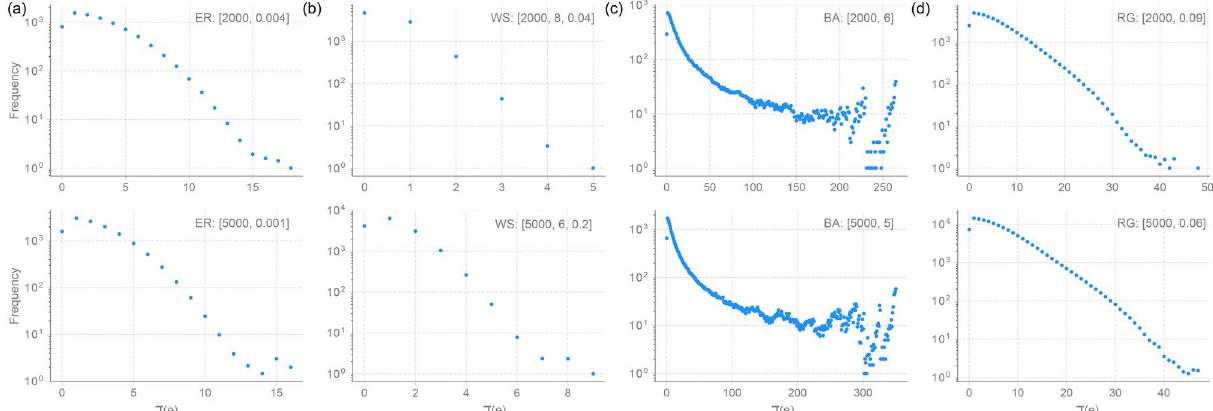
Figure 4. DD distributions in 4 different synthetic networks. ( a ) Erdös–Rényi (ER). ( b ) Watts–Strogratz (WS). ( c ) Barabási–Albert (BA). ( d ) Random Geometric (RG). For each model, the parameters used are indicated besides it in parenthesis. For ER model, the parameters are number of vertices n and probability p of connecting an edge between any pair of vertices. For WS model, the parameters are number of vertices n , the number of neighbours k to which each vertex is connected in the starting regular graph, and rewiring probability β . For BA model, the parameters are number of vertices n and number of edges β that are attached to the new vertex at each iteration step. For RG model, the parameters are number of vertices n and radius ǫ . The reported correlation for each model and a given set of parameters is an average over a sample of 50 networks.